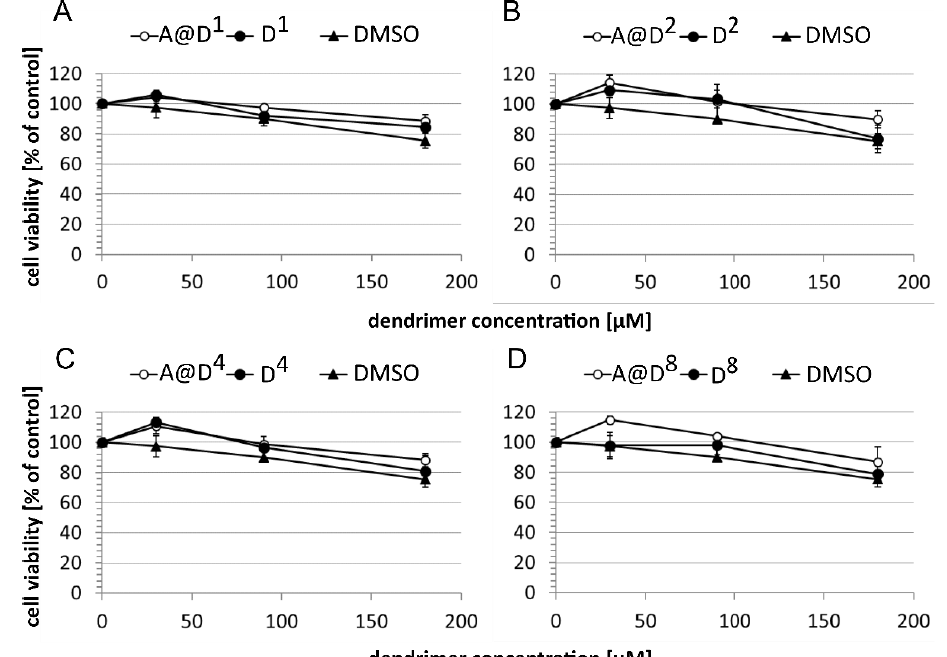
Figure 4. Viability of Caco-2 cells after treatment with G3 PAMAM dendrimer conjugates: ( A ) A@D 1 , D 1 ; ( B ) A@D 2 , D 2 ; ( C ) A@D 4 , D 4 , and ( D ) A@D 8 , D 8 at concentrations of 30, 90, and 180 µM. The concentrations of DMSO were 0.5%, 1.5%, and 3%, respectively. Data are presented as means ± SD normalized to untreated control.